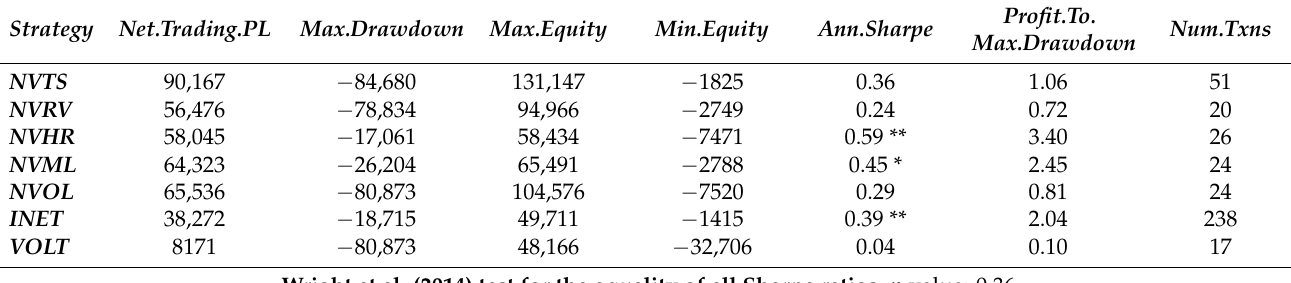
Table 7. Selected comparison of trading strategies: 10% and 90% quantiles